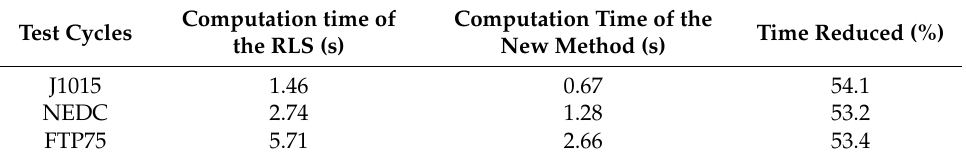
Table 2. Computation time cost of the identification algorithms.